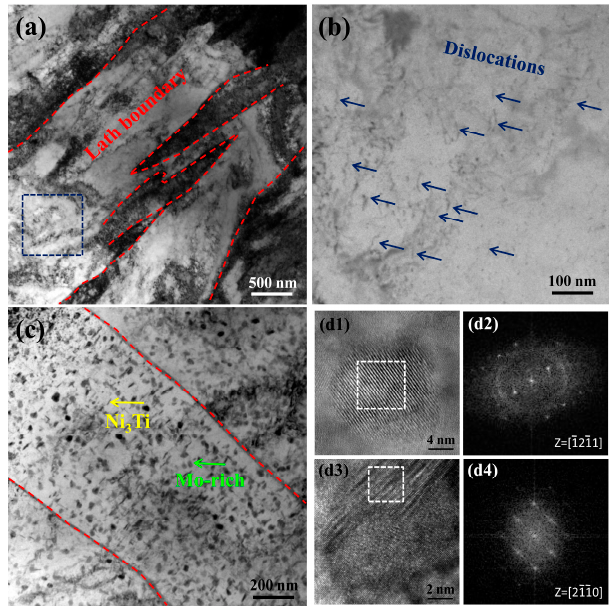
Figure 2. Microstructure characterization by high-resolution TEM (transmission electron microscope). ( a ) Typical martensitic lath in the specimen after CT (cryogenic treatment) treatment, lath boundary